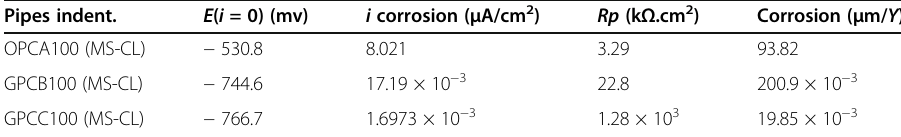
Table 8 The variation in electrochemical results of the reinforcing steel after exposure to accelerated corrosion setup Pipes